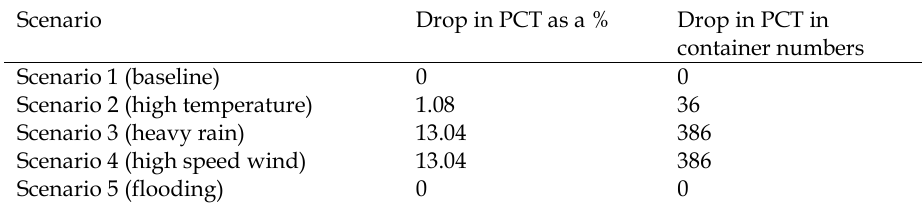
Table 11. Impact on port crane